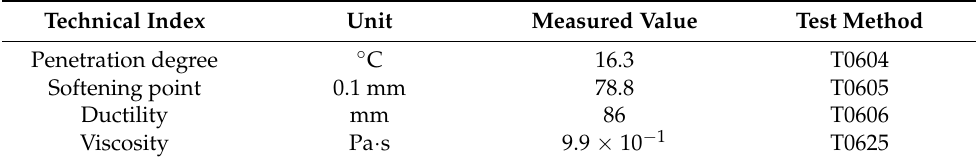
Table 2. Performance index of aging asphalt after extraction.